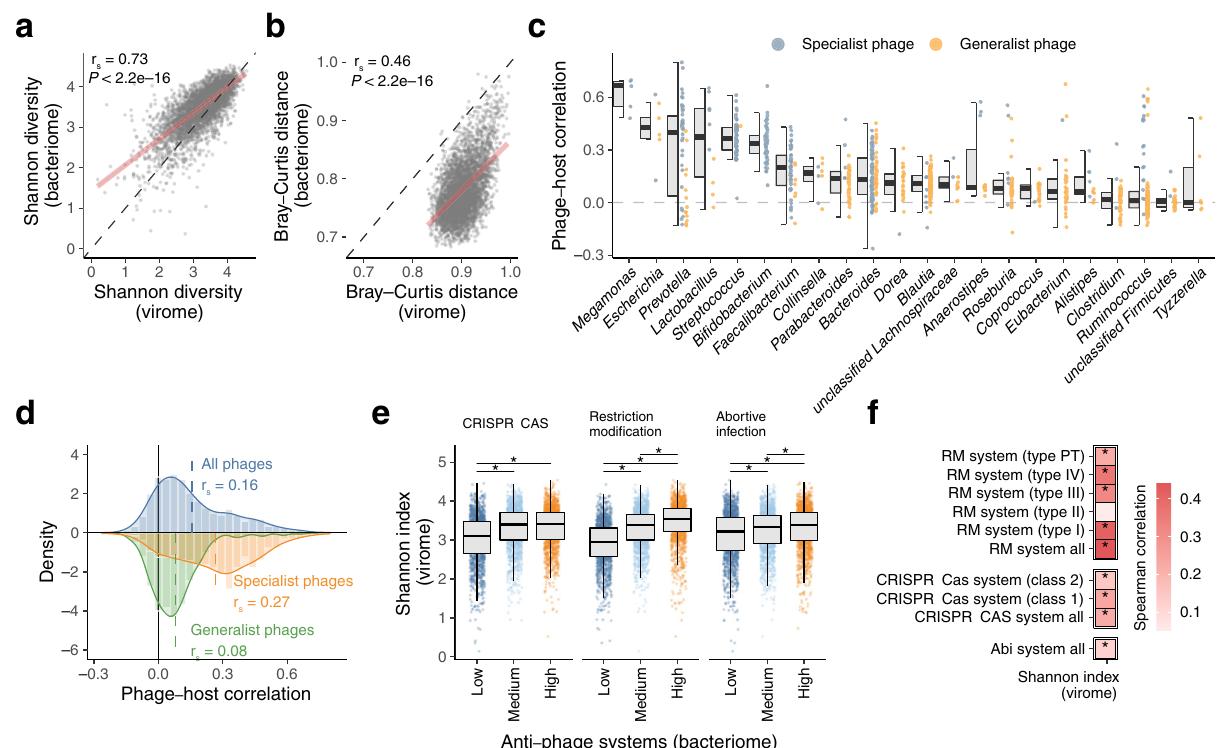
Fig. 3 | Close interactions between the gut virome and bacteriome. Compar- isons of α -diversity (Shannon index) ( a ) and average β -diversity (Bray-Curtis dis- tance) ( b ) between the virome and bacteriome of the human gut ( n =4,198 individuals). In b each circle represents the average value of the Bray-Curtis dis- tance against other individuals. Regression lines are indicated in red. vOTU level and species level pro fi les of the virome and bacteriome were used, respectively. c Spearman correlations between relative abundances of vOTUs and predicted hosts at the genus level. Blue and orange circles represent specialist phages (i.e. phages predicted to infect only one genus) and generalist phages (i.e. phages predicted to infect more than one genus), respectively. Twenty-two genera (aver- age relative abundance > 0.1%) with at least 5 vOTUs are shown in the fi gure. d Distributionofphage-hostcorrelationsacrossthe4,198individuals.Blue,orange, and green colours represent the distributions of all phages, specialist phages, and (Supplementary Fig. 8a). At the level of the host bacteria, age had signi fi cant positive correlations with Proteobacteria phages and host unknown phages, but a negative correlation with Actinobacteria pha- ges(r s = 0.10,0.12and − 0.07,respectively, P -values<0.05,Fig.4b),also